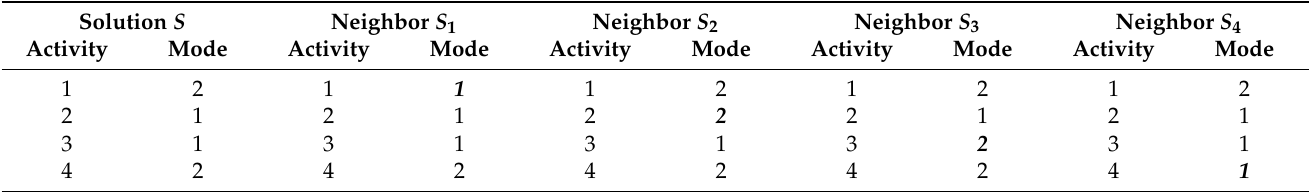
Table 3. Neighborhood structure example.